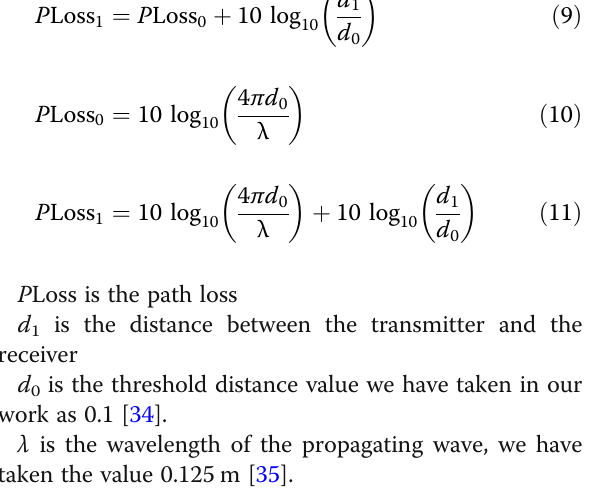
Table 3 The comparison between various parameters for PSO, ALO and GWO Parameters Algorithms Network lifetime (rounds) Throughput Number of packets received